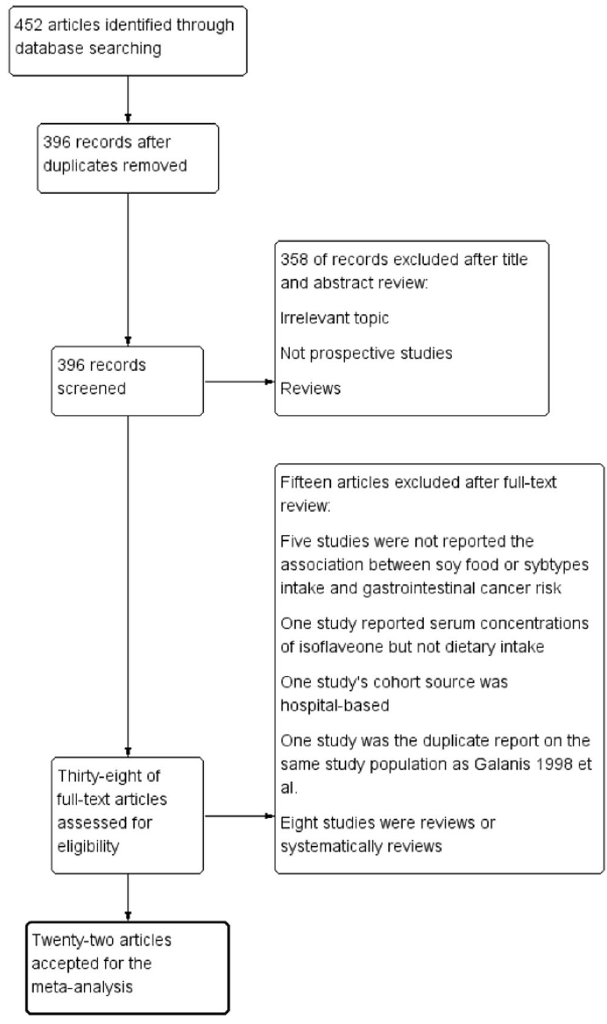
Figure 1. Flow diagram of selection process for inclusion studies in the meta-analysis of soy consumption and GI cancer